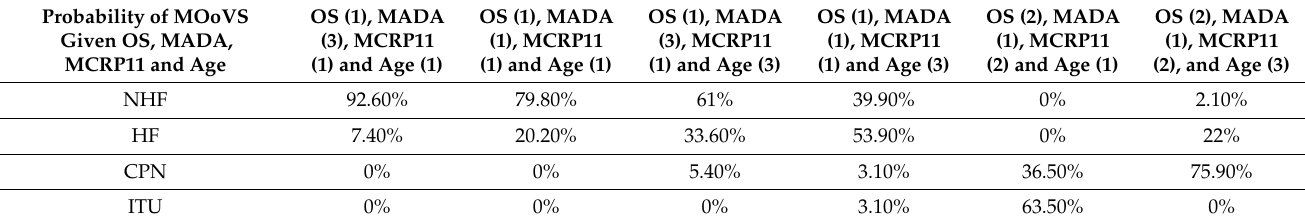
Table 10. The heat-mapped, conditional probabilities of MOoVS given the different configurations of Age, MADA, OS and